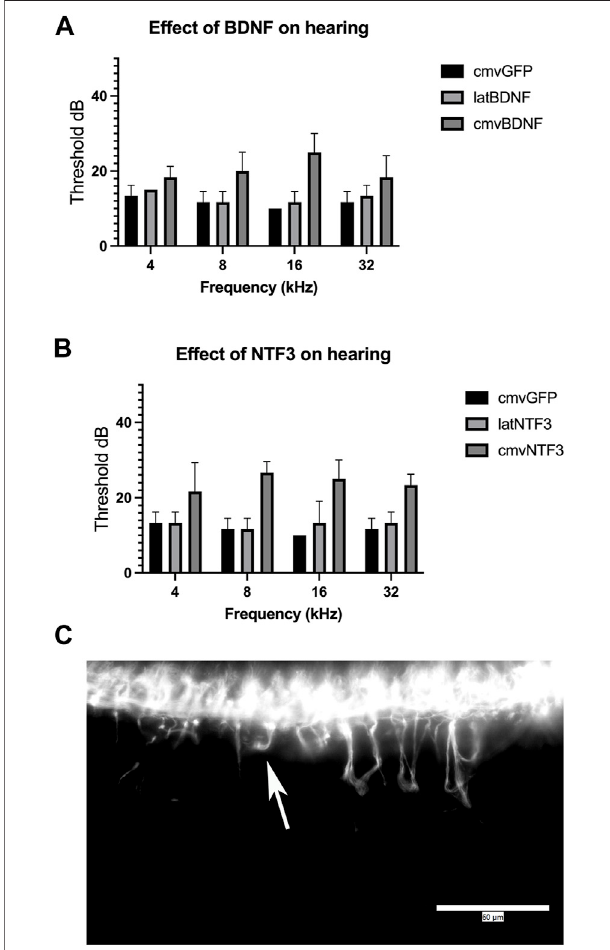
FIGURE 4 | Effect of neurotrophin expression in the normal hearing ear. Expression of BDNF in the cochlea appeared to induce a mild change in hearing when expressed at high levels using the CMV promoter (A) . This was not signi fi cant compared with expression driven by the lat promoter or overexpression of GFP driven by the CMV promoter. Overexpression of NTF3 at high levels caused signi fi cant elevation of thresholds at 8 k, 16 k, and 32 kHz,compared withlat-drivenNTF3or control inner ears (B) . Evaluation of spiral ganglion neurons by immuno fl uorescence demonstrated abnormal migration of spiral ganglion neurites after delivering the NTF3 gene with a strong promoter [ (C) , Arrow]. Error bars represent standard deviation ( n = 5). Scale bar = 60